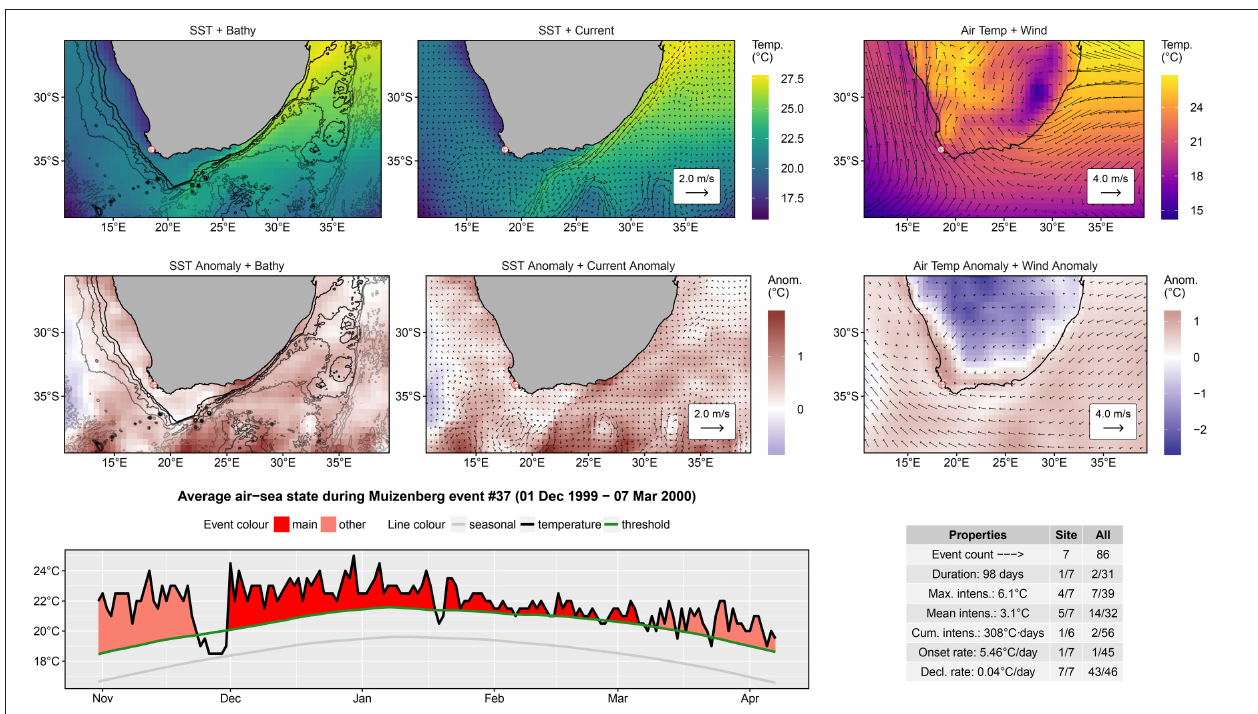
FIGURE 2 | An atlas figure for a single coastal marine heatwave (MHW). The location of collection for the in situ coastal seawater temperature time series is shown in each of the top six panels as a white dot with a red border. The top row of panels shows the mean synoptic atmospheric and oceanic states during the MHW, created by averaging all daily synoptic atmosphere-ocean states during the event. The middle row shows anomalies for the mean atmospheric and oceanic states during the event. The left hand panel in the bottom row shows the period of the time series in which the MHW occurred. The table in the bottom right corner shows the values for the relevant metrics of the event as explained in Table 1 as well as its ranking against other events at the same site and the entire study area. Similar figures for each of the 86 MHWs used in this study are available